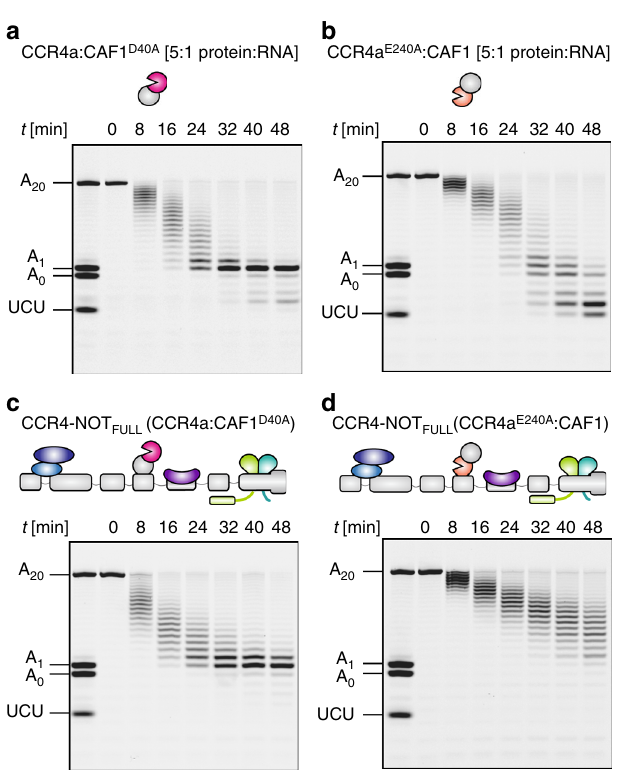
Fig. 3 Comparison of deadenylation activities of CAF1 and CCR4a. a , b Deadenylation assays with the 7-mer-A 20 RNA substrate (50 nM) and a fi ve-fold molar excess of the CCR4a:CAF1 exonuclease heterodimer (250 nM) containing inactivating mutations in either CAF1 ( a ; D40A mutation) or CCR4a ( b ; E240A mutation), respectively. Both mutations decrease the rate of deadenylation compared to wildtype (Fig. 2c), and the CAF1 D40A mutation ( a ) improves the selectivity of the exonuclease heterodimer for adenosine. c , d Deadenylation assays with equimolar concentrations (50 nM) of 7-mer-A 20 RNA and CCR4-NOT FULL complexes with the catalytically inactivating mutations in CAF1 ( c ) and CCR4a ( d ), respectively. The CAF1 D40A mutation mildly decreases deadenylation activity and leads to increased adenosine speci fi city compared to wildtype (Fig. 2d), while the CCR4a E240A mutation results in a drastically slower deadenylation reaction. Source data are provided as a Source Data fi